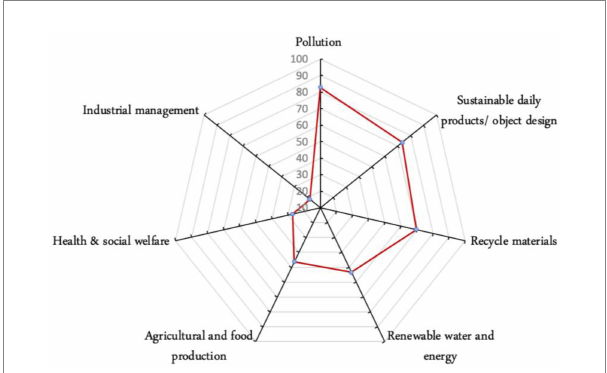
FIGURE 1 Top development issues to be used in the STEM lectures of the surveyed teachers. % Responses were counted based on the topics listed by the surveyed teachers. ( N =